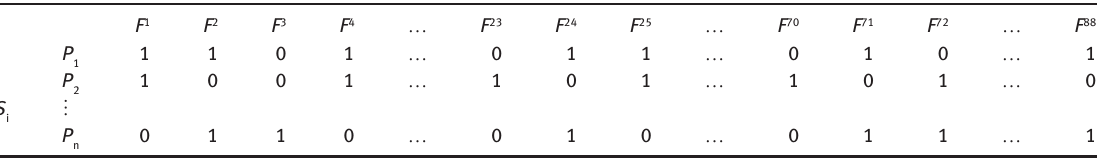
Table 2: Initial Solution Format of